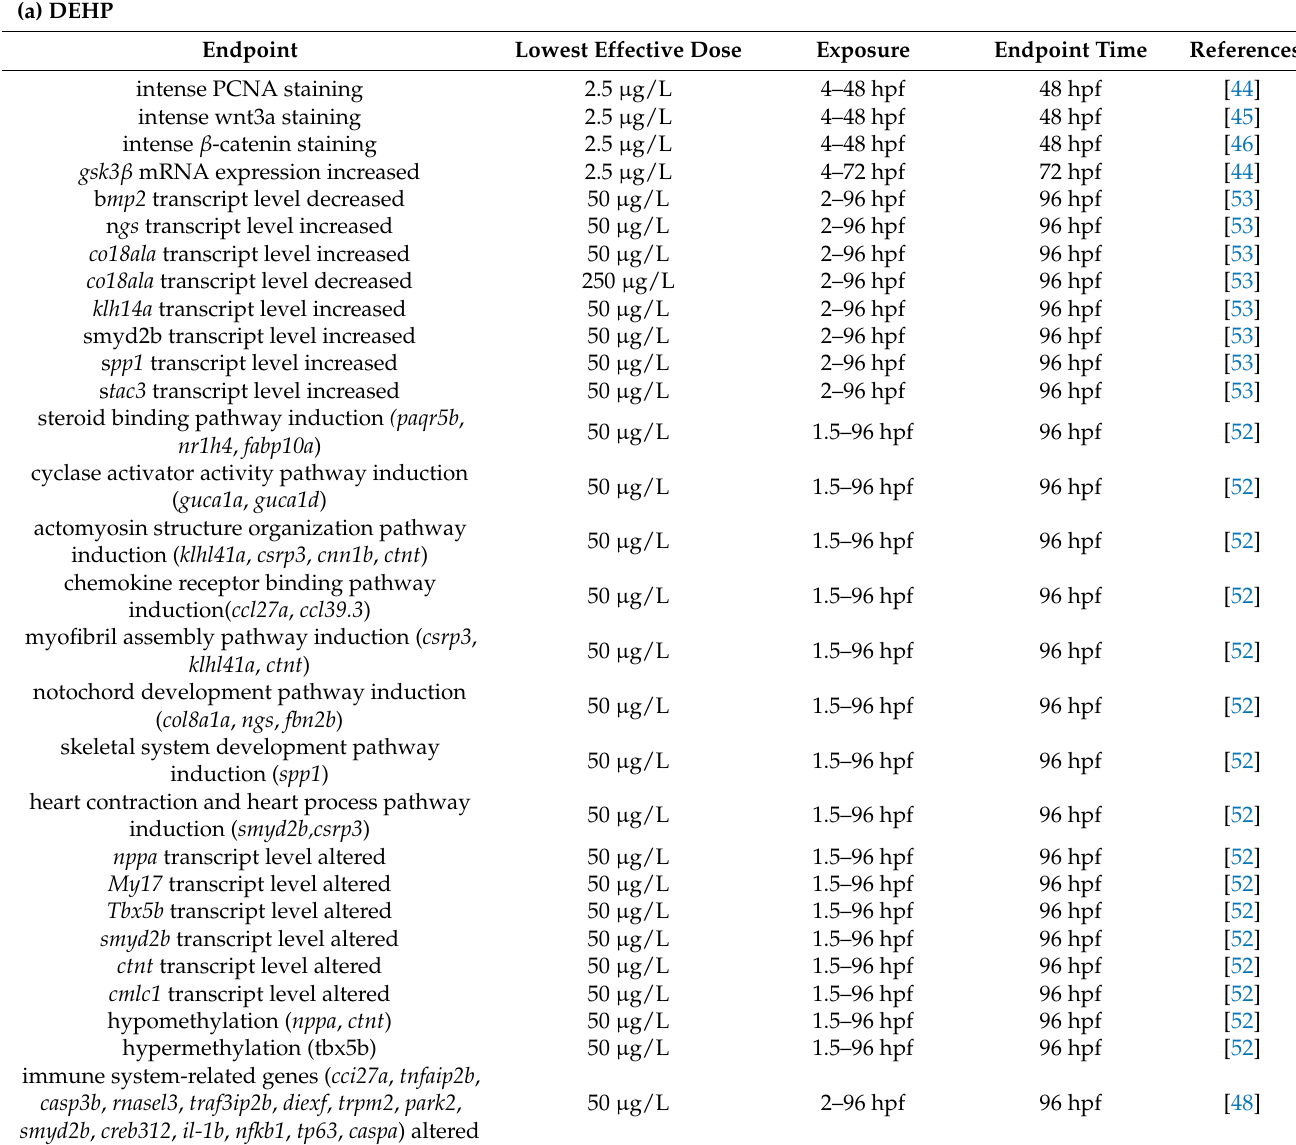
to DEHP or MEHP on zebrafish embryos. Table 6. Regulation of gene and possible mechanisms from acute exposures to (a) DEHP and (b) MEHP on zebrafish embryos. (a)